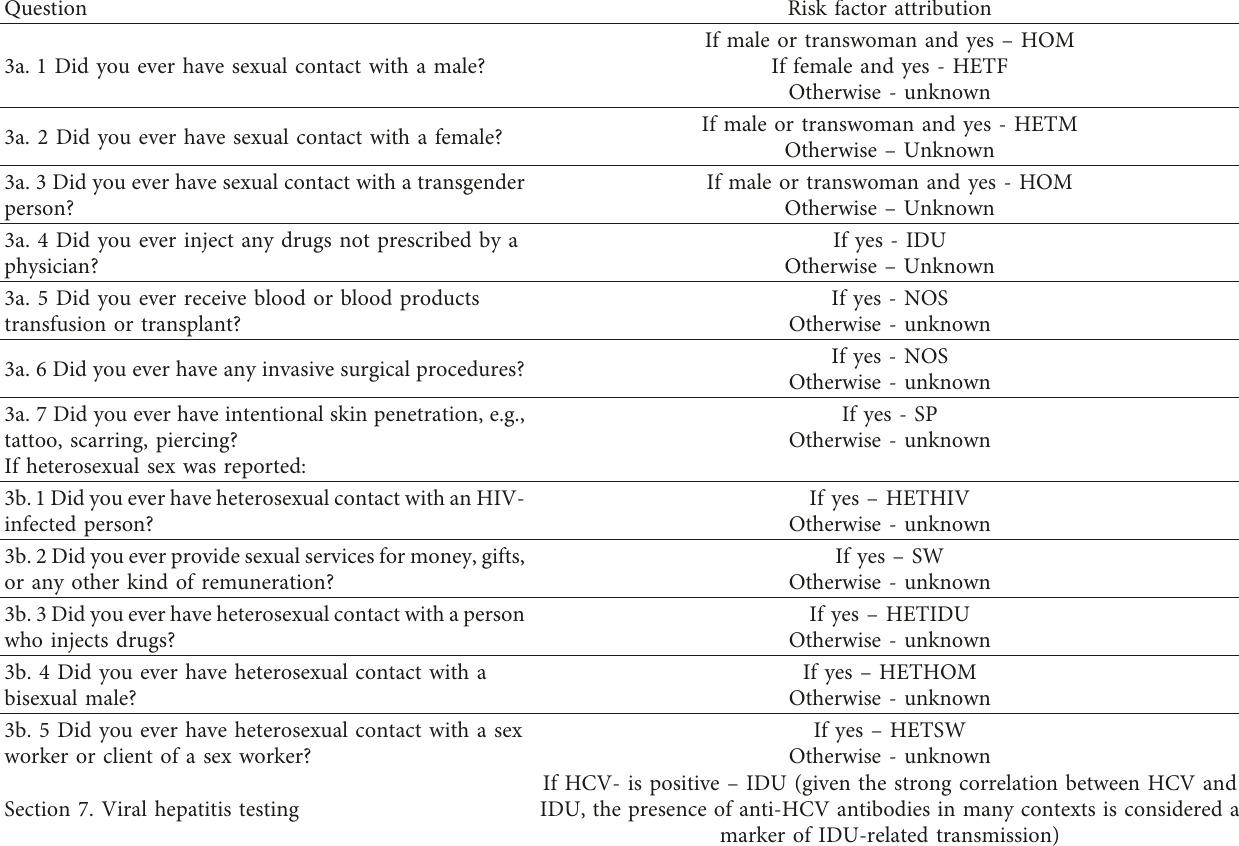
Table 1: Assessment of all the existing risk behaviours based on the following national algorithm.